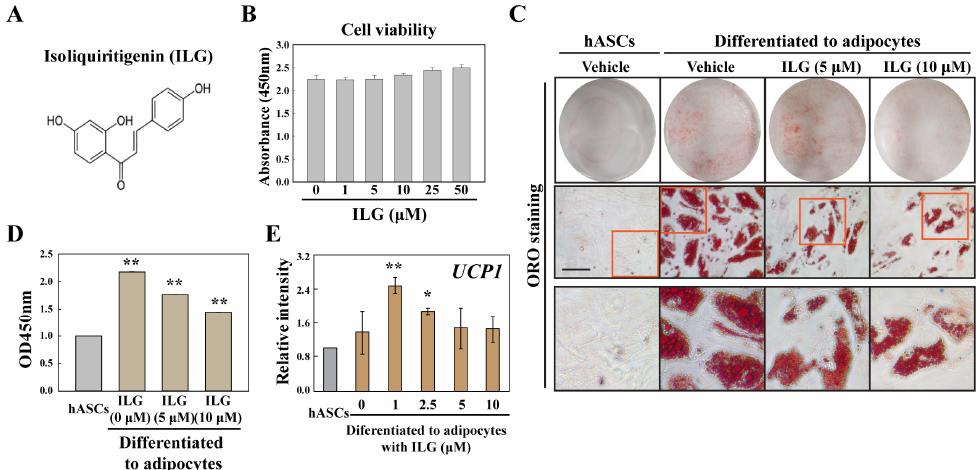
Figure 1. E ff ects of ILG on the adipocyte di ff erentiation of human adipose-derived stem cells (hASCs). ( A ) Chemical structure of ILG. ( B ) The cell viability of ASCs treated with ILG was determined using the CCK-8 assay. Treatment with the indicated concentrations of ILG for 24 h did not cause any significant change in cell viability compared with that of the control group. ( C , D ) Fat droplets were stained with Oil Red O (Scale bar = 200 µ m), and accumulated lipids were quantified by measuring the absorbance. ( E ) Gene expression was analyzed by real-time PCR. Expression levels of UCP1 in low-dose ILG-treated adipocytes di ff erentiated from ASCs. GAPDH was used as an internal control to normalize the expression of the target genes; n = 3 independent experiments; * p < 0.05 and ** p < 0.01.